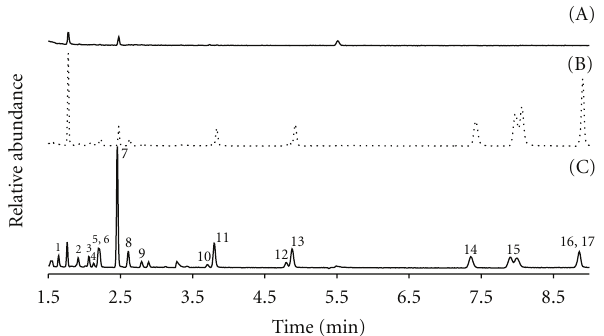
Figure 2: Total ion chromatogram obtained for a blank (A), a passive sampler deployed 24h in a glass container with air spiked at 5.26 mg m − 3 VOCs level (B), and a passive sam- pler spiked with 2.5 μ g of VOCs standard solution (C). Note: peaks correspond to carbon disulfide (1); chloroform (2); 1,1,1- thrichloroethane (3); 1,2-dichloroethane (4); benzene (5); cyclo- hexane (6); 2, 2, 4-thrimethylpentane (7); trichloroethylene